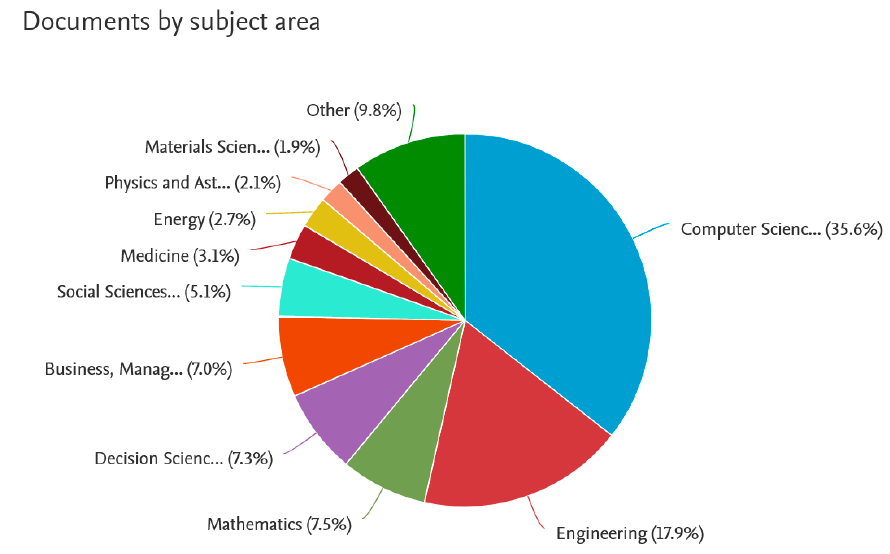
Figure 6. Documents found in Scopus for the “big data analytics” key phrase by subject area.